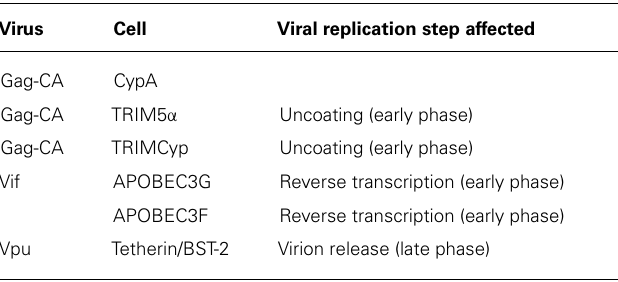
Table 1 | Major viral and cellular determinants for HIV-1 species